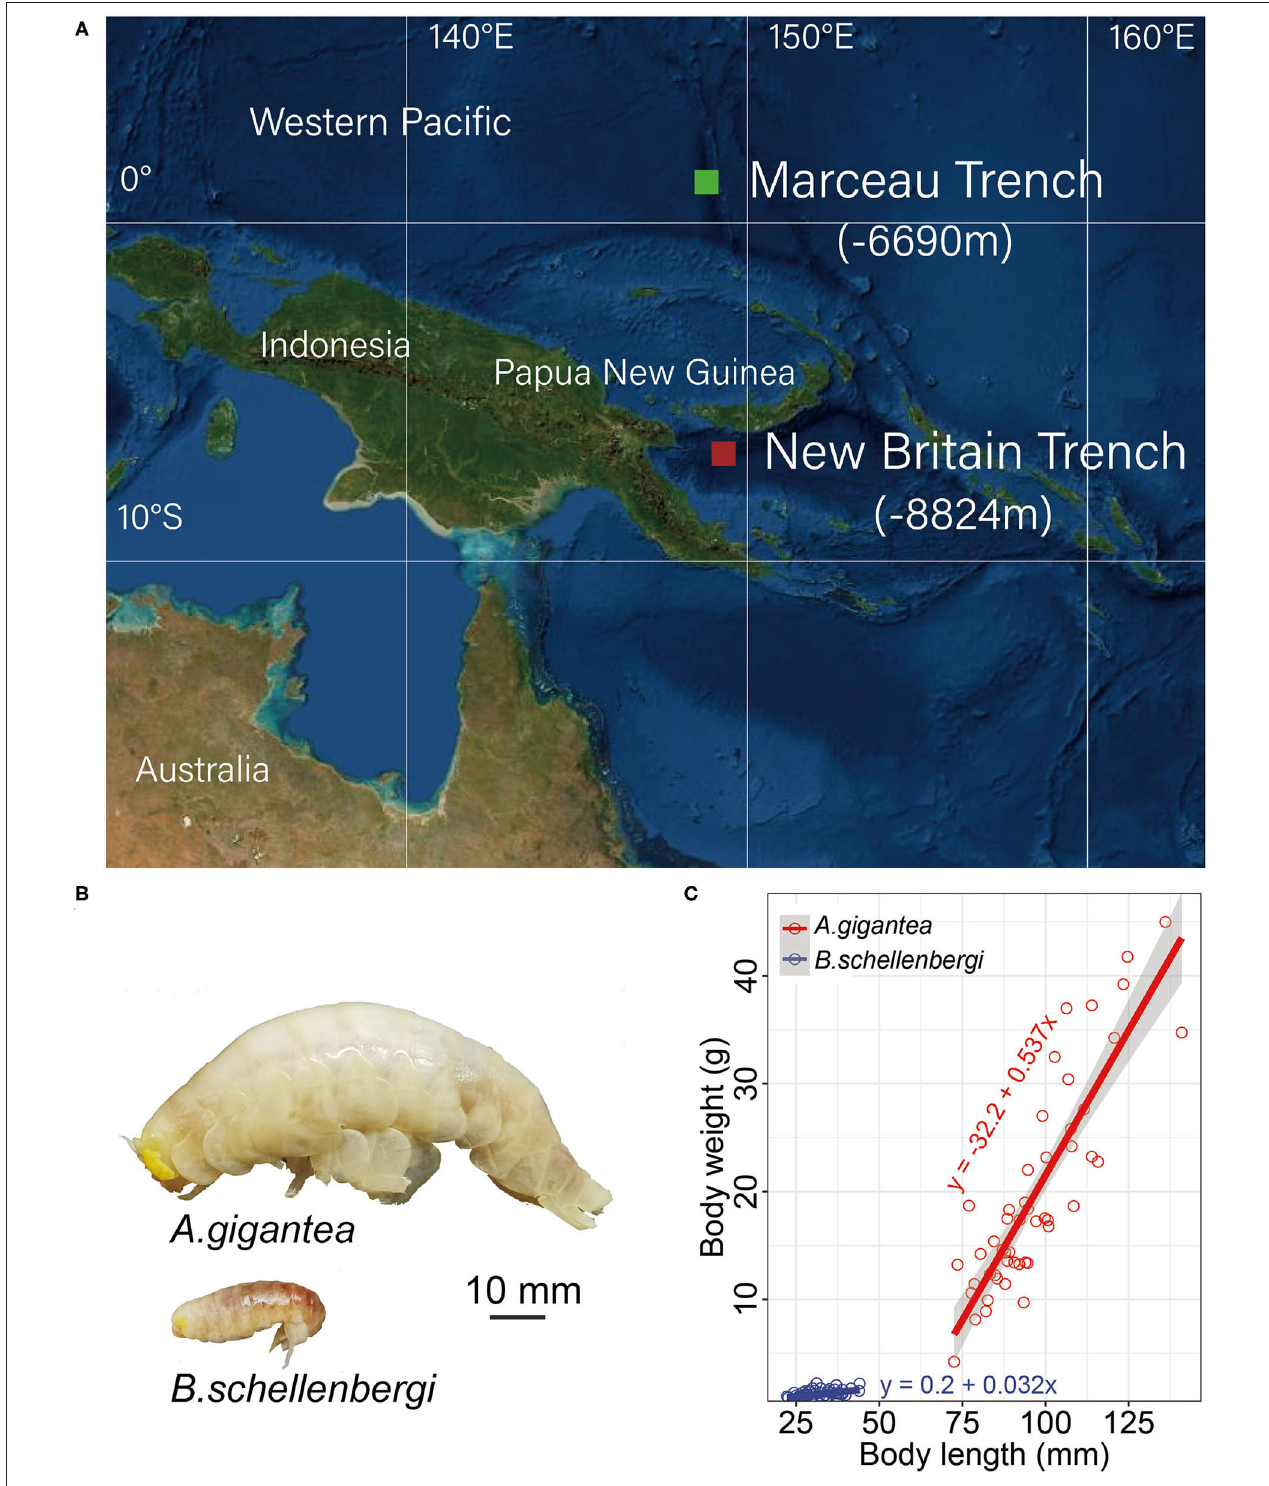
FIGURE 1 | Sample collection and size and weight measurement. (A) The sampling sites of two amphipods were used in this study. Alicella gigantea and Bathycallisoma schellenbergi individuals were sampled from the New Britain Trench (8,224m) (red square) and the Marceau Trench (6,990m) (green square), respectively. (B) The pictures of A. gigantea (upper) and B. schellenbergi (down) exhibited a significant difference in their body size. (C) The growth fitting curves for A. gigantea (red) and B. schellenbergi (blue). About 50 individuals for each species were used for the body length (x-axis, mm) and body weight (y-axis, g) measurement. The linear correlation equations between the body lengths and weights for A. gigantea (red) and B. schellenbergi (blue) were also shown.